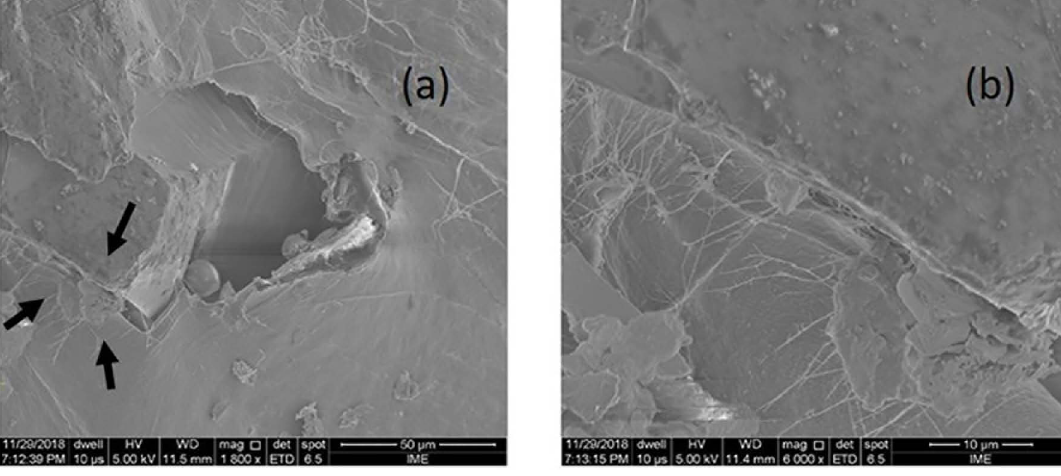
Figure 9. SEM images, after the first impact, (a) of the distal face of an A80/50 sample, showing the region of contact between alumina and UHMWPE, and (b) enlargement of the same region, showing UHMWPE